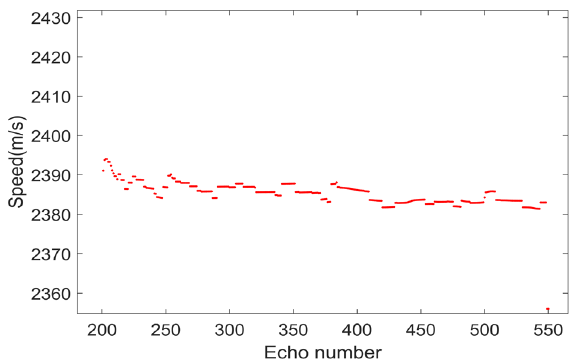
Figure 5. Velocity distribution under 350 echoes.